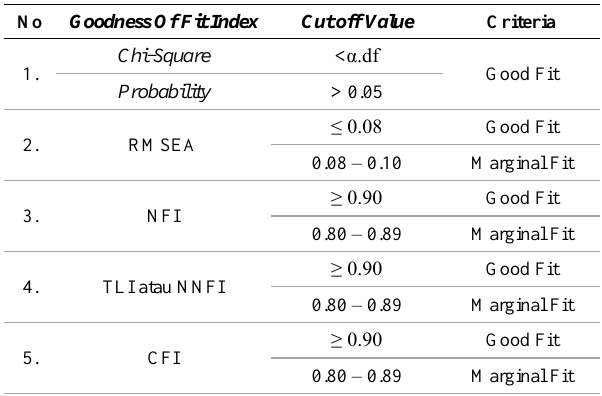
Table 1. Goodness of Fit